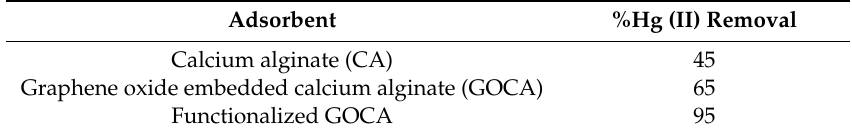
Table 1. Percentage of Hg(II) adsorption using various types of alginate